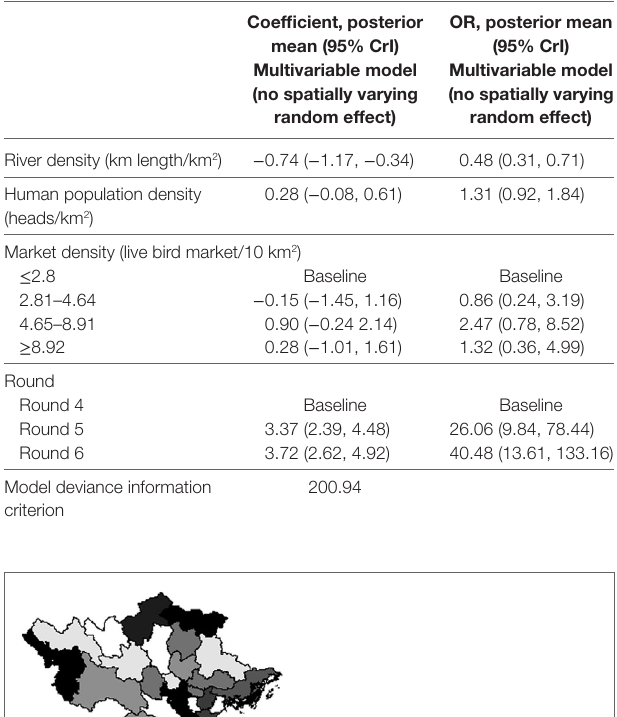
TaBle 5 | Posterior mean coefficients, odds ratios (ORs), and 95% credible intervals (CrI) of non-spatial conditional autoregressive models of market days positive for highly pathogenic avian influenza H5N6 virus (Vietnam, 2011–2015).